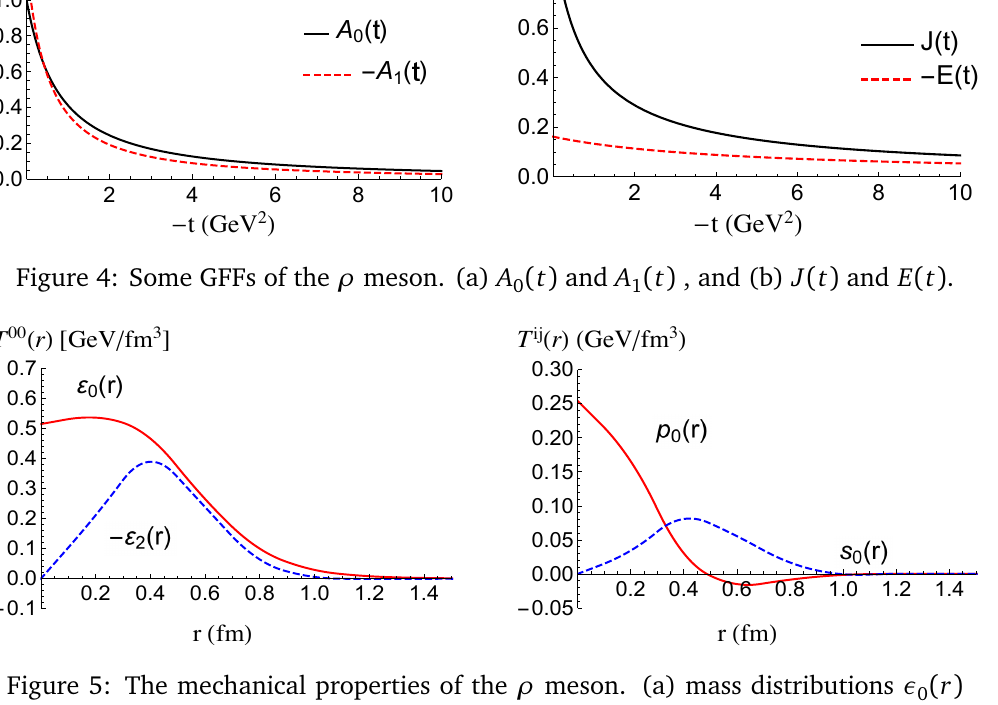
( r ) and pressure p 0